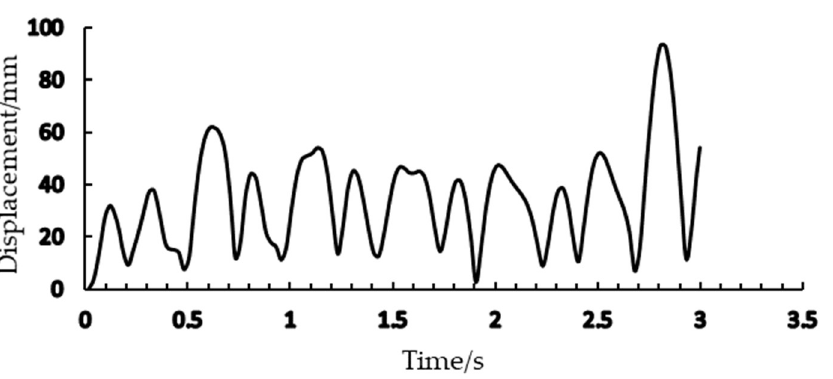
Figure 14. Simulated displacement results of the right end of spray boom.